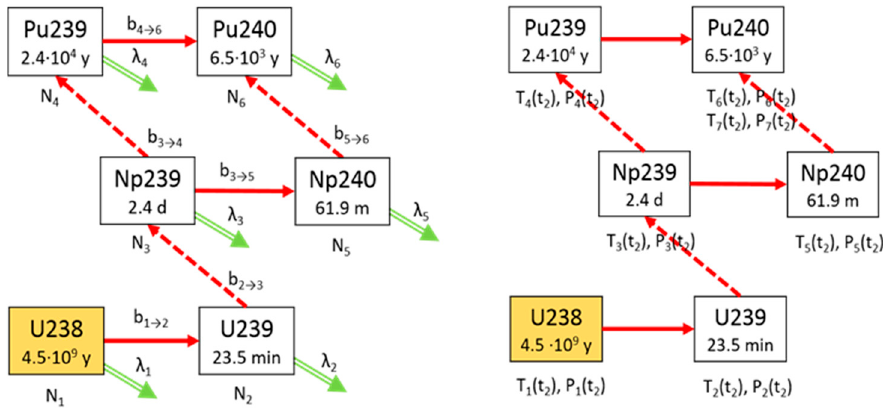
Figure 6. Decomposition of a fragment transformation map of decay and transmutation reactions (left) to linear chains (right).